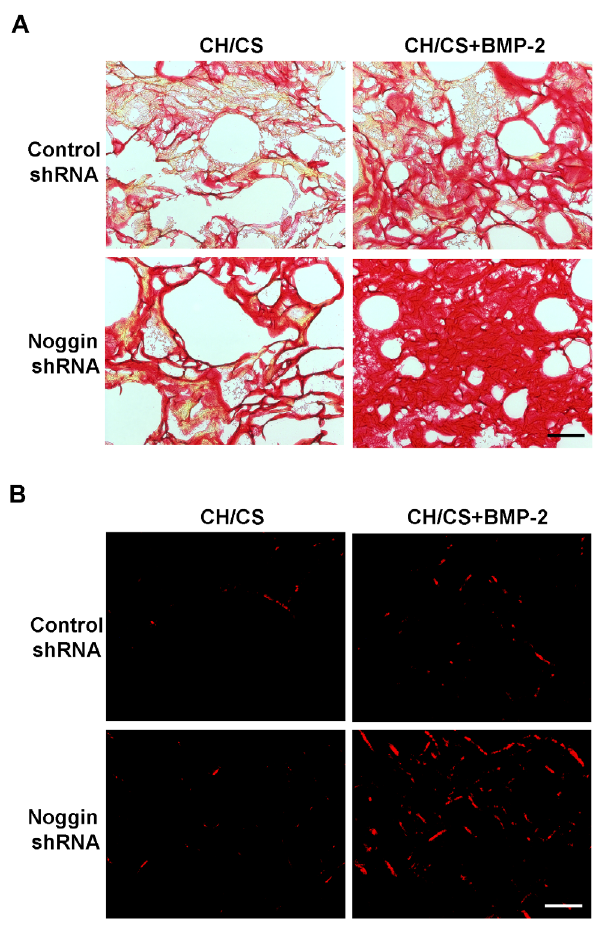
Figure 7. Collagen deposition of ASCs cultured in apatite- coated CH/CS scaffolds releasing BMP-2. Picrosirius red staining of ASCs cultured on CH/CS scaffolds for 21 days, which was assessed by bright field (A) and polarized light (B) microscopy. Scale bar = 100 m m. Significantly higher collagen deposition was observed in noggin suppressed ASCs cultured on CH/CS scaffolds releasing